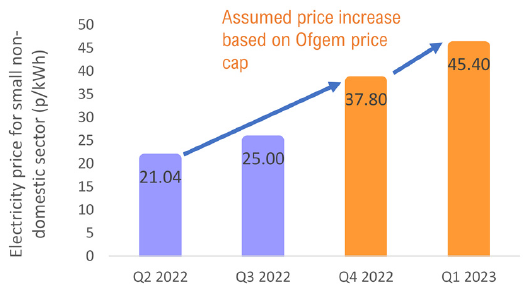
Figure 5. Assumed electricity price for small non-domestic sector from October 2022.